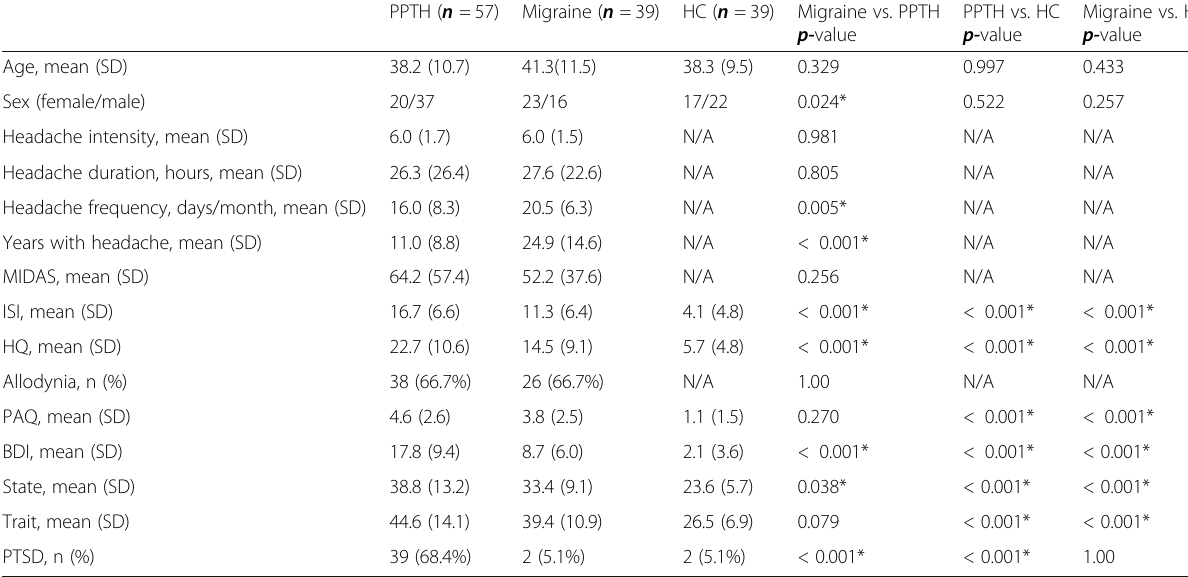
Table 1 Subject demographics and clinical characteristics by group